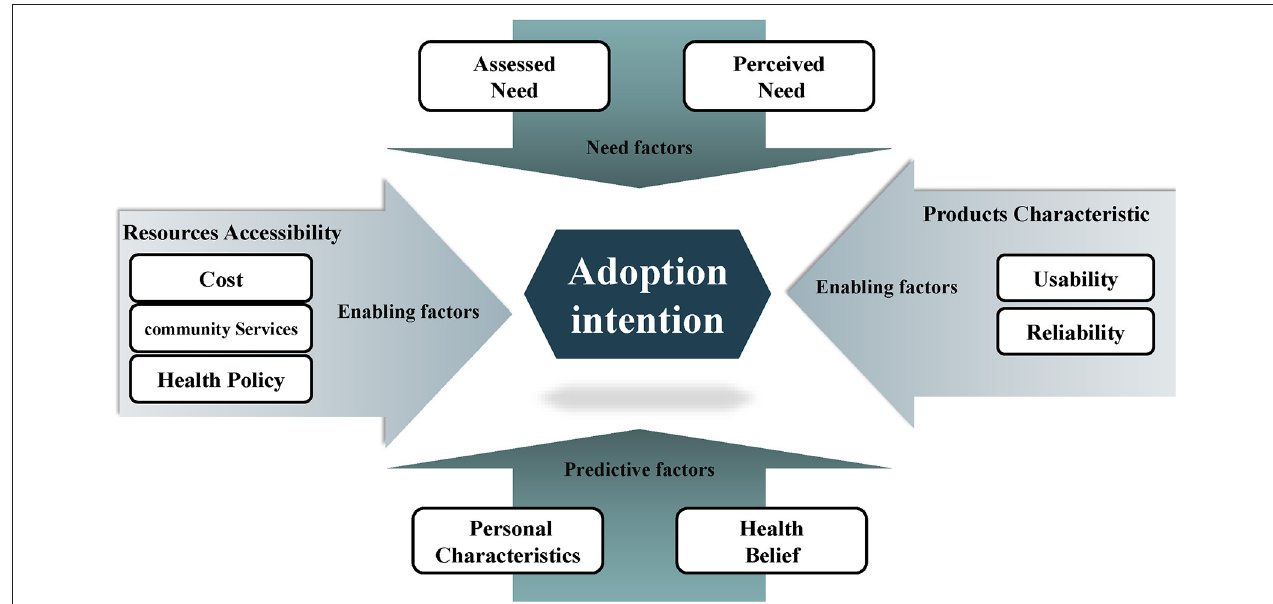
FIGURE 3 | Conceptual model of influencing